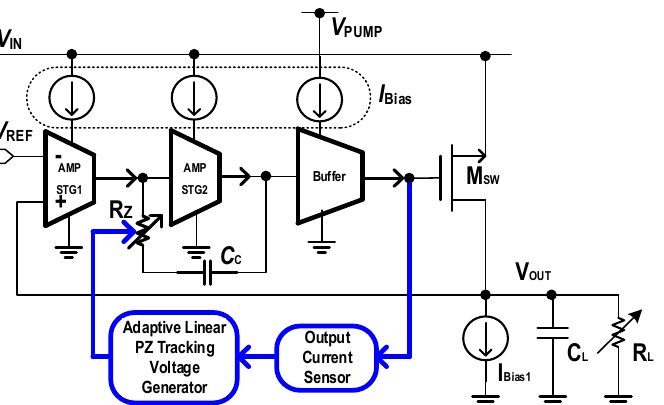
Figure 3. Proposed structure of regulation circuit with the adaptive linear pole − zero tracking compensation. (R Z is the equivalent impedance of the NMOS M RZ ; I Bias and I Bias1 are bias currents. V PUMP is the high − level supply voltage in the USB interface protecting circuit.)